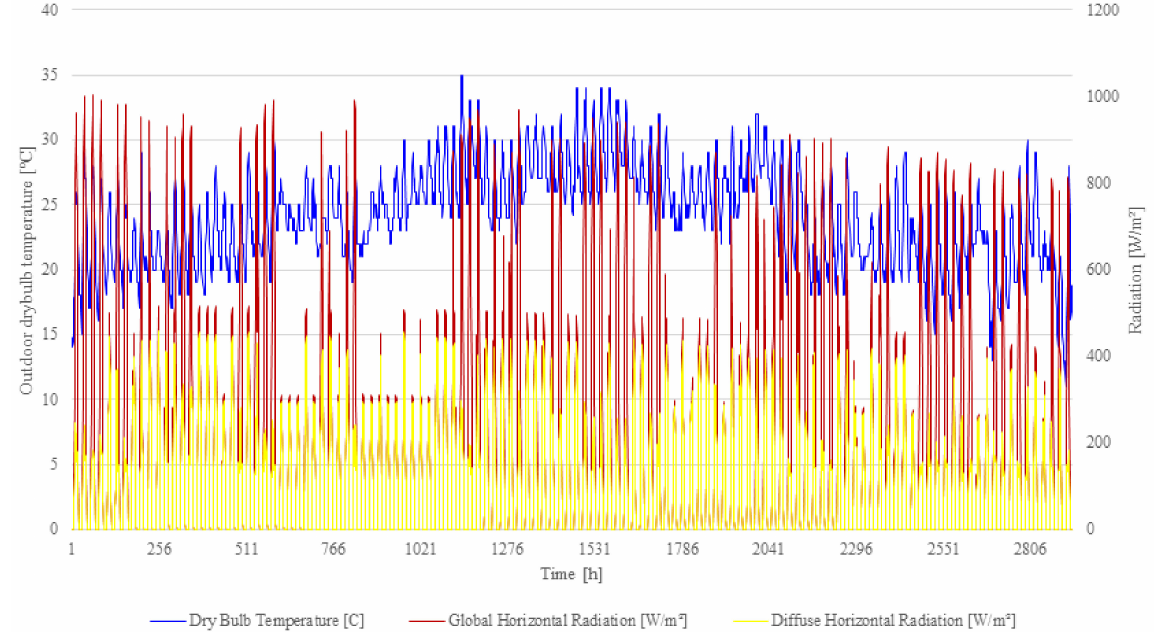
Figure 11. Muan weather data in Jeollanam-do (dry bulb temperature, solar radiation).